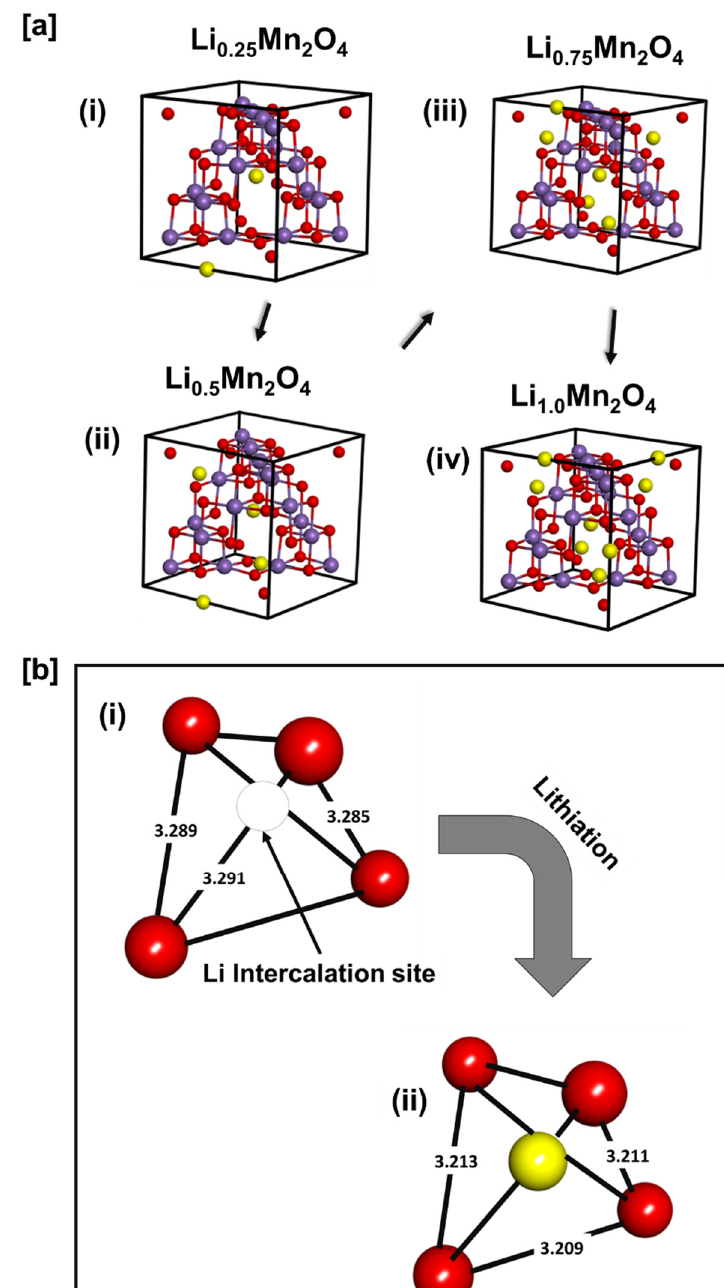
Figure 4. ( a ) The Intercalation of lithium atoms into the tetrahedral sites of spinel Li x Mn 2 O 4 (0.25 ≤ x ≤ 1). (i) Li 0.25 Mn 2 O 4 , (ii) Li 0.5 Mn 2 O 4 , (iii) L i0.75 Mn 2 O 4 and (iv) Li 1.0 Mn 2 O 4 ; ( b ) Lithium intercalation into a (i) vacant tetrahedral site of spinel Li x Mn 2 O 4 (0 ≤ x ≤ 1) structure.